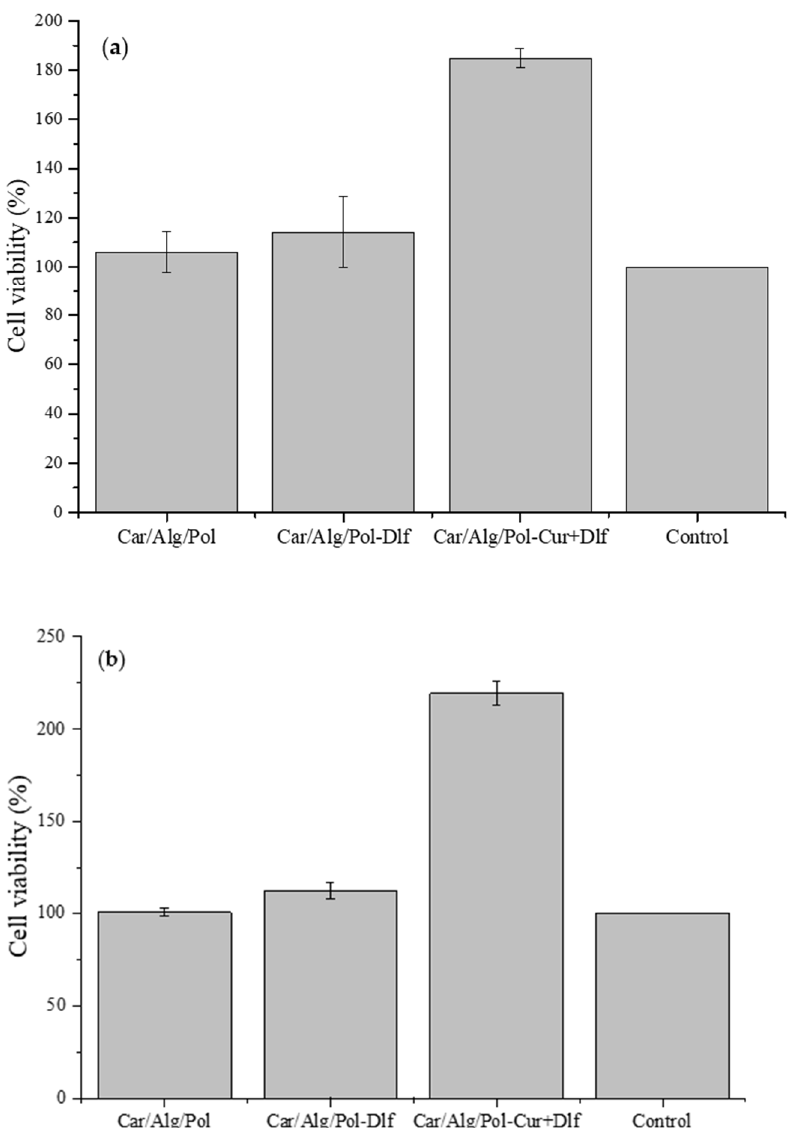
Figure 10. Influence of the Car/Alg/Pol, Car/Alg/Pol-Dlf i Car/Alg/Pol-Cur+Dlf films on MRC-5 cell viability after ( a ) 24 h and ( b ) 48 h.